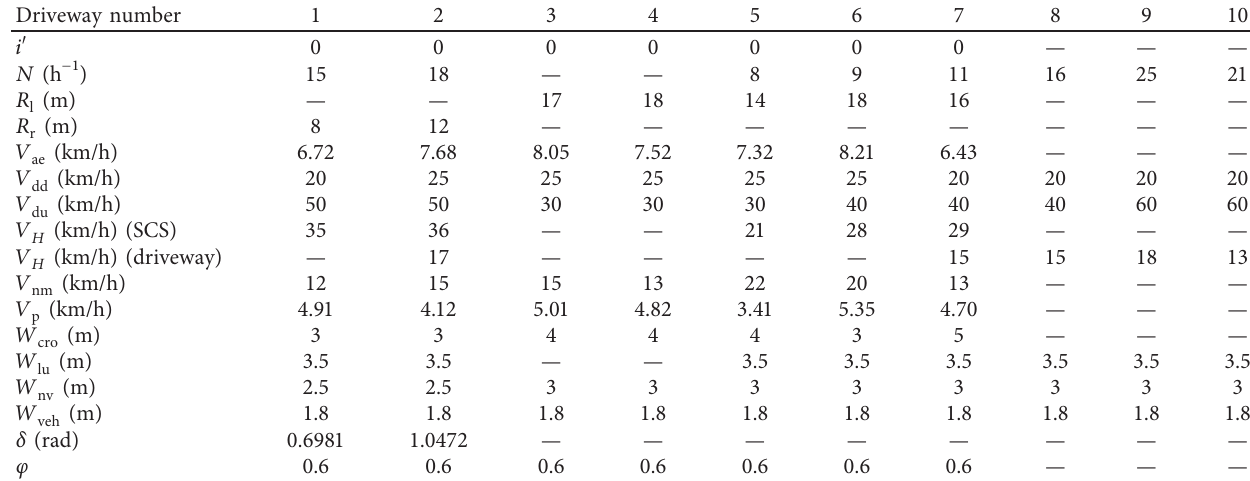
Table 5: Other collected driveway traffic data.